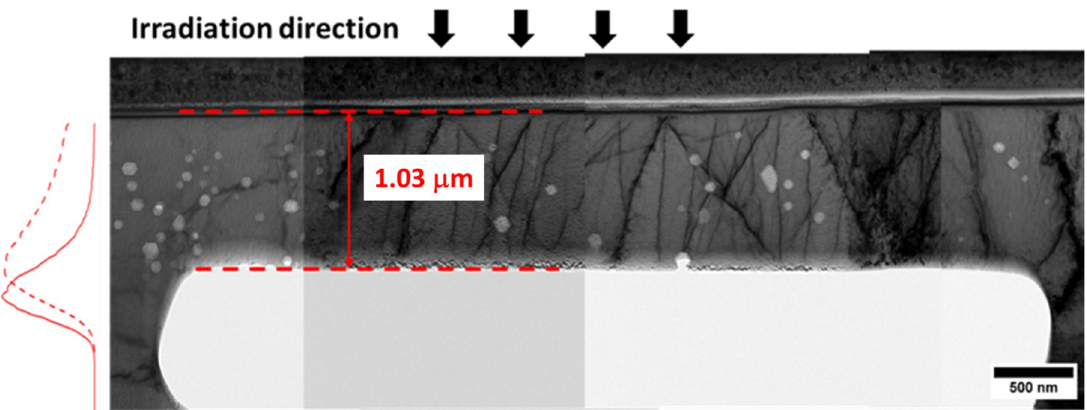
Figure 10. TEM micrograph of irradiated Fe, obtained by repeating the same trenching procedure and FIB lift-out after ion irradiation, in the order of (1) ion irradiation, (2) trenching, and (3) FIB lift-out. Note that the order of experimental steps is different from Figures 3-9.